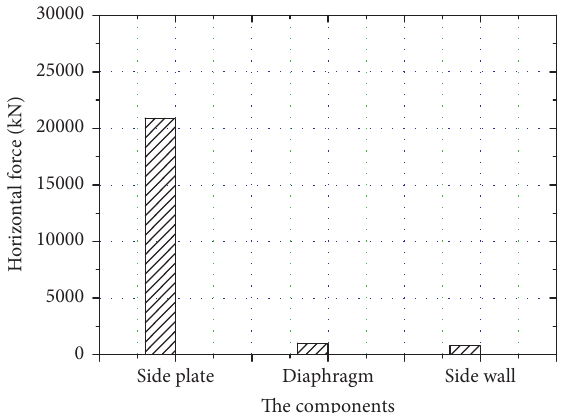
Figure 4: Horizontal force borne by each component.